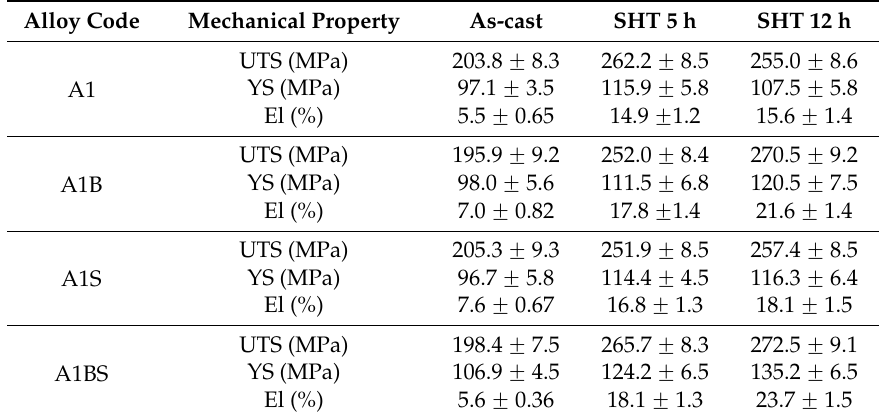
Tensile properties of A1, A1B, A1S, A1BS alloys in the as-cast and solution heat treated condition.